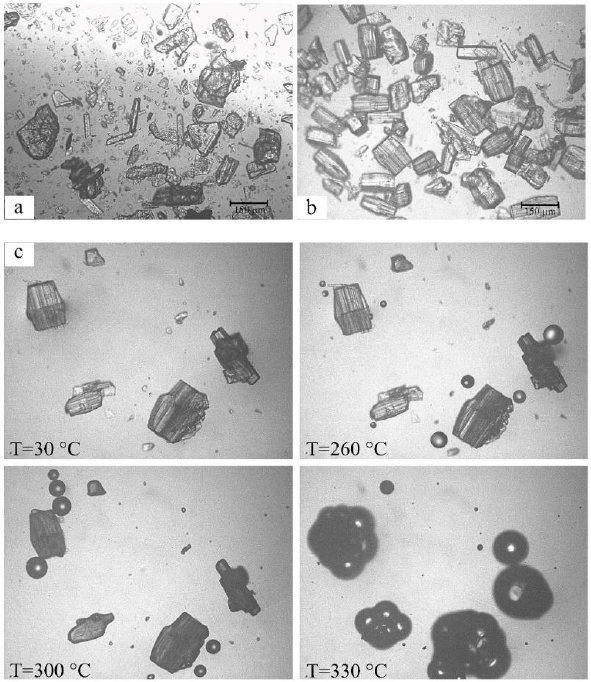
Figure 12. Photomicrographs of the RSV - γ-CD PM ( a ) and the CCP sample ( b ) at room temperature, and HSM micrographs of CCP at the various temperatures reported on the images ( c ).